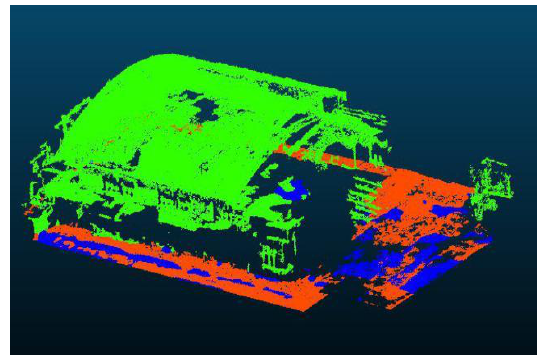
Figure 4: Point Cloud Dataset for Dewan Muafakat